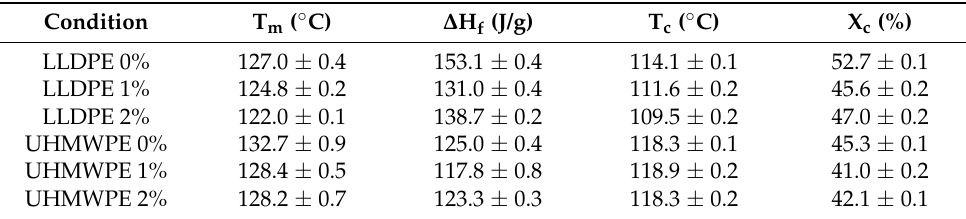
Table 1. Thermal properties of LLDPE and UHMWPE with 0%, 1% and 2% peroxide. Condition